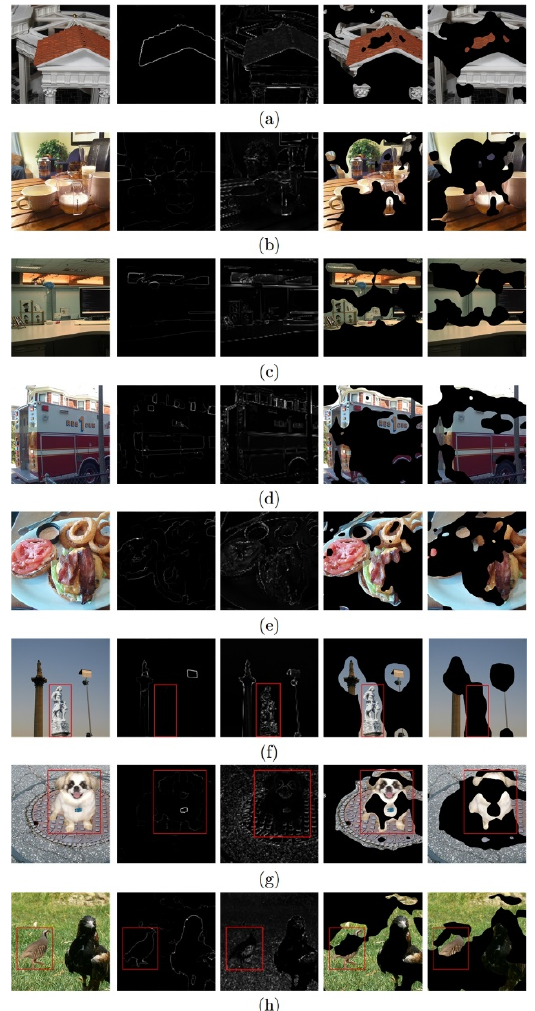
Figure 13. Images that cannot be correctly detected by all the algorithms. From left to right are the color images, the chroma detection results of CCW, the results of the sharpness detection operator, and the ROI and RONI given by the CCW salient map. ( a – e ) Untampered images; ( f – h ) tampered images.